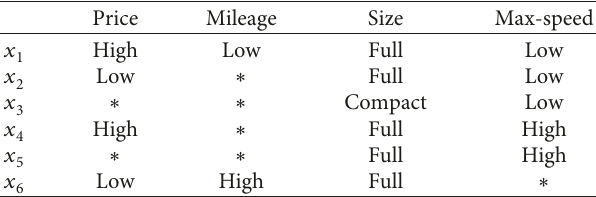
∗ T sv R S λ N B , B . B ,and